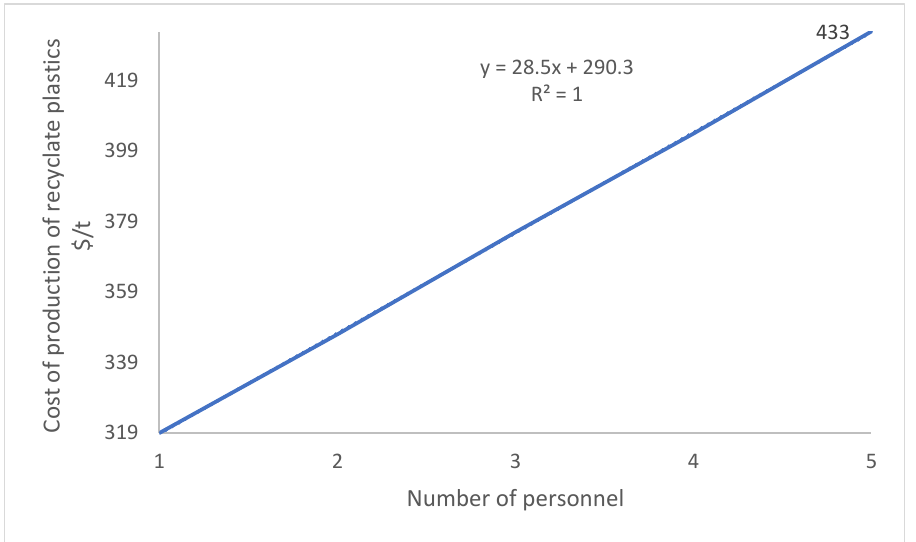
Figure 9. The effect of chemical cost on the cost of production of recyclate plastics. From Figures 6, 7 and 9, zero electricity cost, zero labor cost, and zero chemical cost would result in the least cost of production of recyclate plastics of 289, 290, and 313 USD/t. Moreover, clinical plastics recycling cannot be stimulated at all under any condition of gas or electricity price. The lowest electricity price of 160 USD/MWh at the lowest gas price of 47 USD/MWh still result in an infeasible cost of production of 356 USD/t of recyclate plas- tics that is on the higher side of their prices. Recyclate plastics price at the least price of gas and crude oil is likely to be on the lower side of prices, 287 USD/t. At this low selling price, plastics recycling can only be stimulated by applying a gate fee to plastic waste from